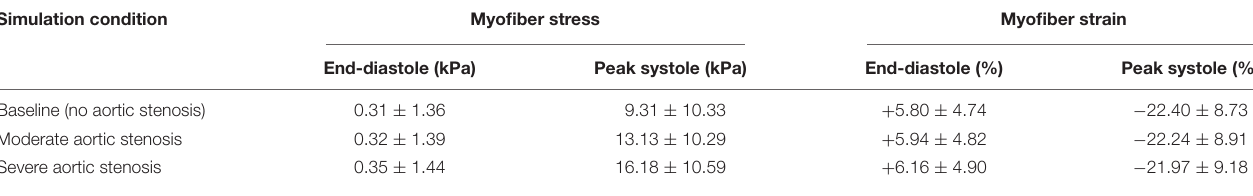
TABLE 1 | Global myofiber stress and strain in the left ventricle. Simulation